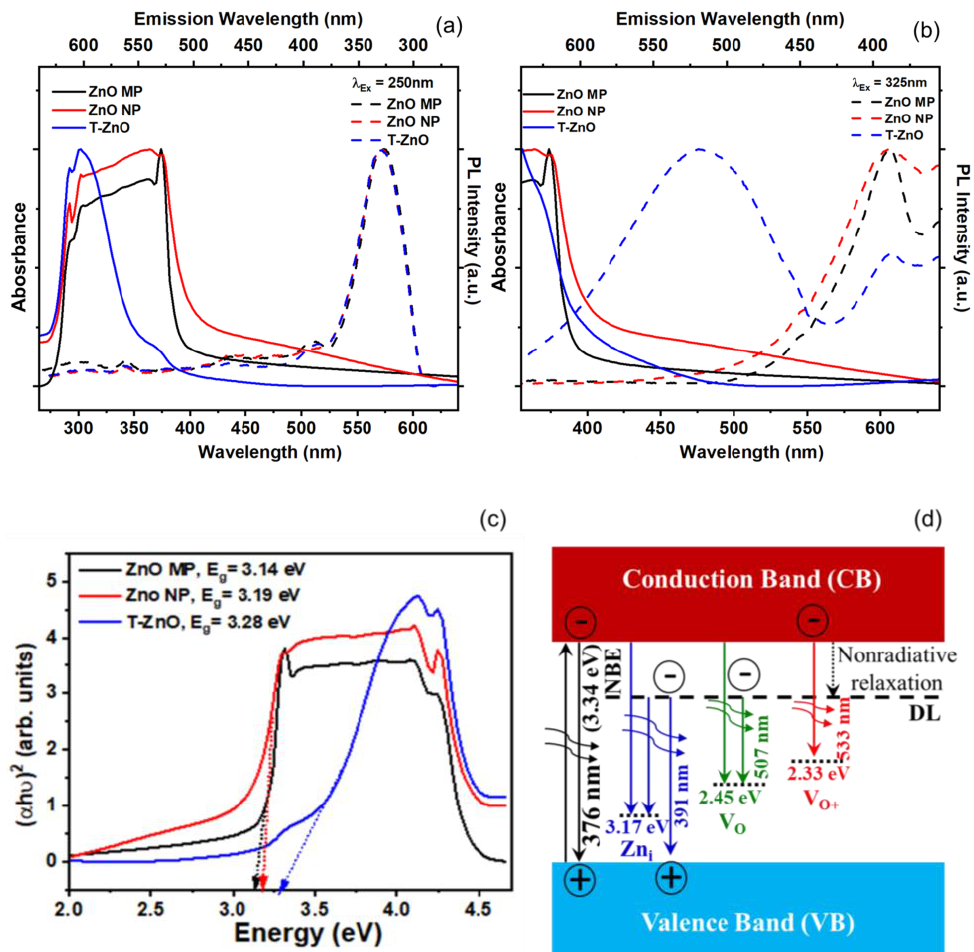
Figure 3. Optical spectroscopy of ZnO–MP, ZnO–NP, and T–ZnO. ( a , b ) UV–visible absorption spectra (absorbance) and photoluminescence (PL) spectra. ( c ) The calculated bandgap from Tauc gap. ( d ) energy levels schematic of near band edge. (NBE) and native point defects in ZnO lattice showing defect level (DL).